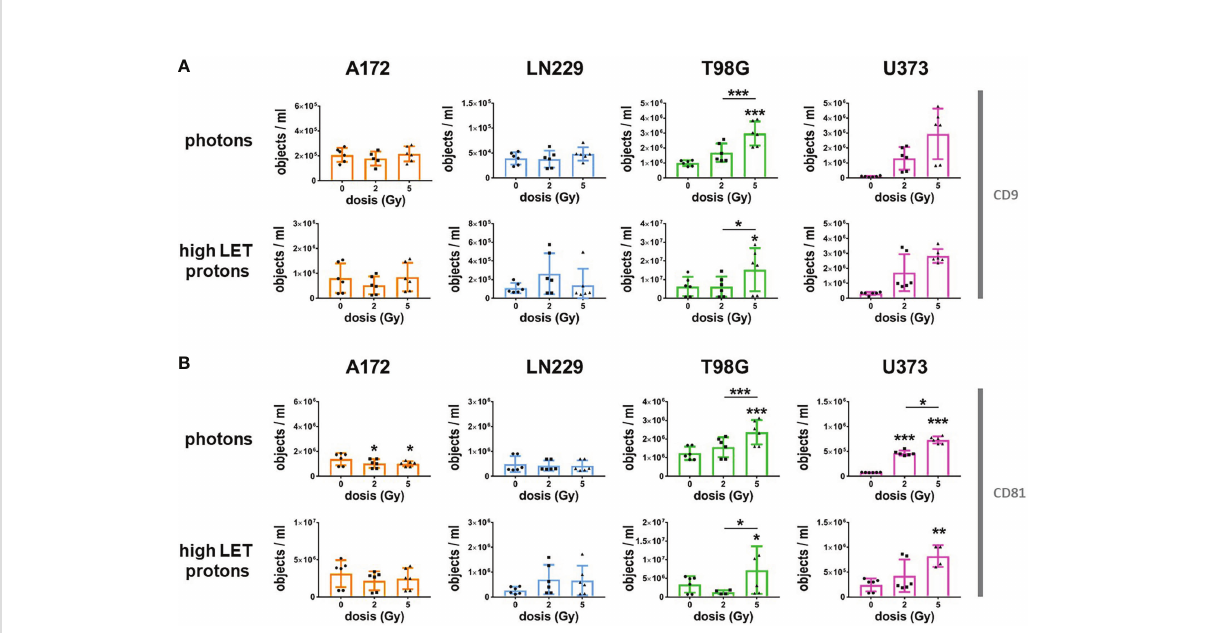
FIGURE 5 Radiation increased secretion of CD9 and CD81-positive EVs in T98G and U373 cells. 24 h after plating, glioblastoma cells were irradiated with photons or high protons at 0 Gy, 2 Gy or 5 Gy. Directly after irradiation, medium was replaced by 2 mL of EV-free culture medium. Supernatant was collected 72 h after irradiation and number of CD9- (A) or CD81-positive (B) objects was determined by using IFCM analyses. N = 4-6. *, ** and *** above the bars indicate signi fi cance to respective non-irradiated controls until otherwise indicated. *p < 0.05; **p < 0.01; ***p <